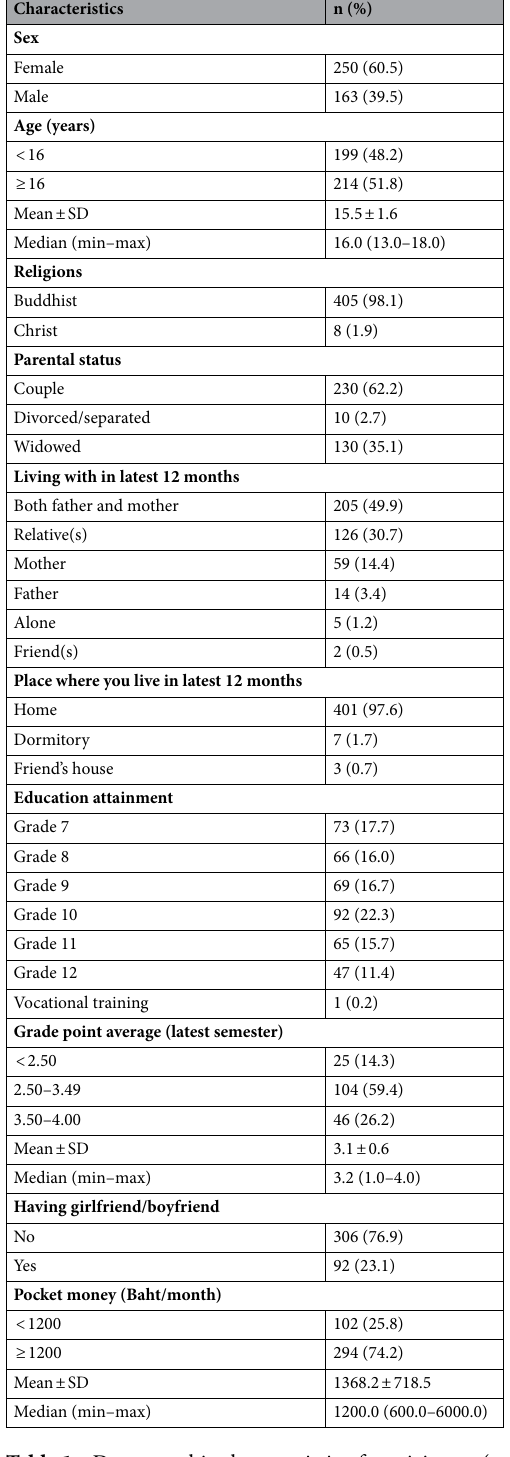
Table 1. Demographic characteristic of participants (n = 413). SD standard